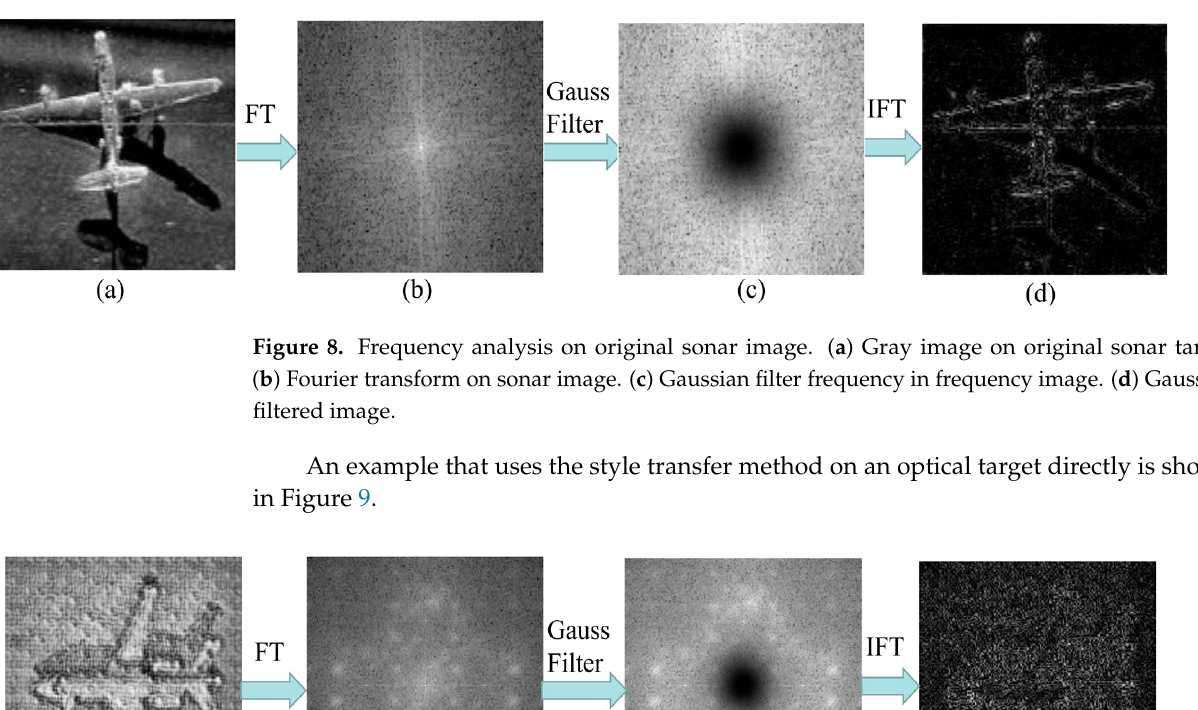
Figure 7. Example of shadow and reflector on real sonar target.